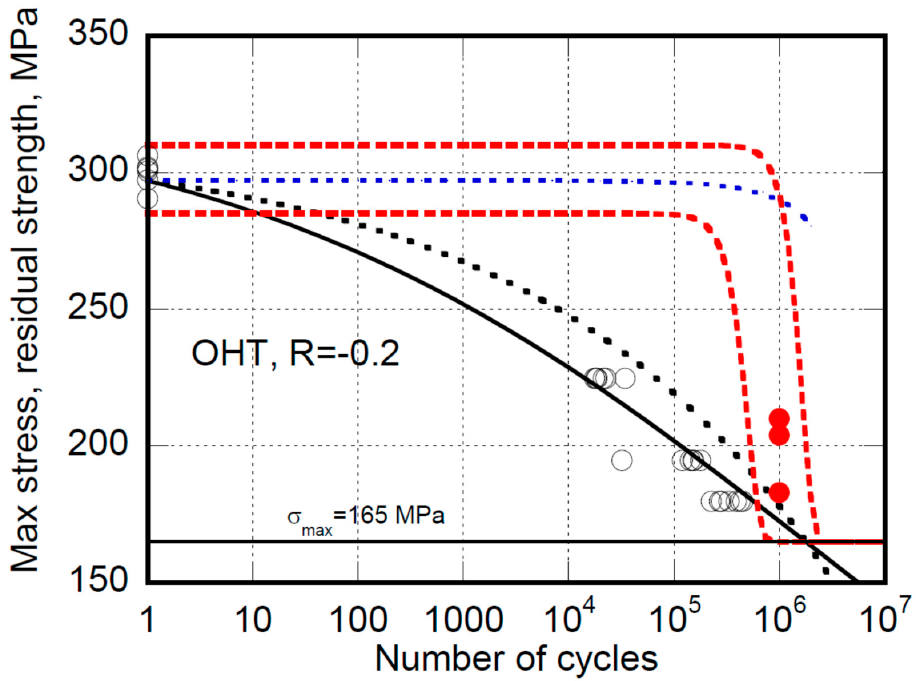
Figure 5. The experimental fatigue life (circles) and residual strength (filled circles) data for open hole AS4 / E7K8 PW—10 / 80 / 10, under prevalent tension (OHT) at R = − 0.2. The continuous curve is the best fit to the fatigue life data based on Caprino’s and D’Amore’s equivalent models. The broken black curve is the predictions of residual strength from Caprino’s model, namely Equation (9). The broken red curves are the predictions of upper and lower bound of residual strength from the D’Amore’s model, namely Equation (13). The blue dotted line represents the Sendekyj’s model’s residual strength predictions, namely Equation (5’’).